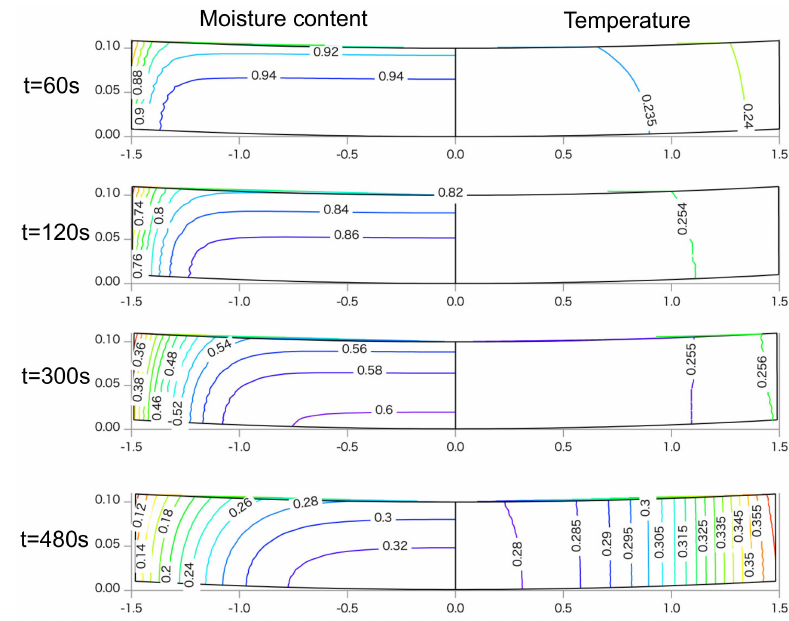
Figure 8. Moisture profiles and deformation behavior during one side drying (hot air temperature 100 ◦